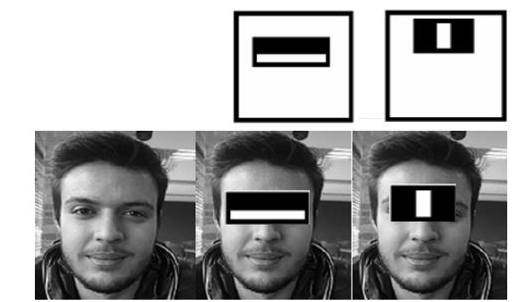
Fig. 1. Haar features on a person’s